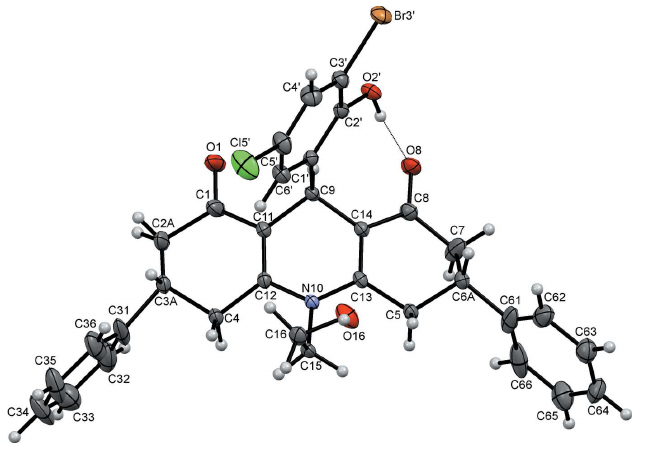
Figure 1 The structure of (I) with ellipsoids drawn at the 50% probability level. For clarity only the major disorder components of the two cyclohexenone rings are shown. An intramolecular hydrogen bond is drawn as a dashed